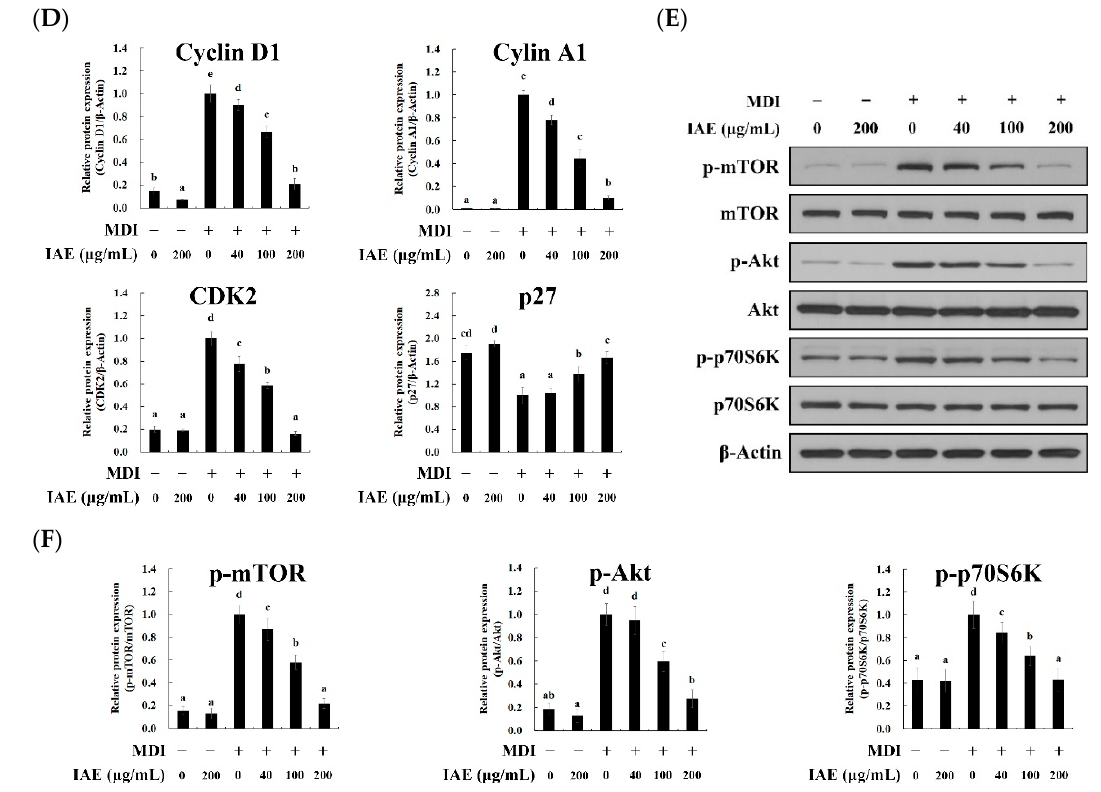
Figure 4. Inula britannica flower aqueous extract (IAE) inhibits the MCE involving Akt signaling pathways during early phase of adipogenesis. Growth-arrested 3T3-L1 preadipocytes were induced to differentiate by stimulating with MDI in the presence of indicated concentrations of IAE. The phosphorylation of cdc2 (Tyr15) and mTOR (Ser2448), Akt (Ser473), and p70S6K (Ser371) was examined to evaluate the activation of the G2/M phase and mTOR/Akt/p70S6K axis, respectively. ( A ) After 16 h of MDI treatment, cell cycle progression was investigated using FACS. ( B ) The cell distribution in the G0/G1, S, and G2/M phases was calculated as a percentage of total cell numbers based on the results of FACS analysis. ( C ) Western blotting was used to examine the expression of cell cycle progression-associated proteins after 18 h of MDI treatment. ( D ) Relative expression levels of representative proteins contributing to the transition of the cell cycle. ( E ) Effect of IAE on the activation of the mTOR/Akt/p70S6K axis after 18 h of MDI stimulation. ( F ) Relative expression levels of phosphorylated mTOR, Akt, and p70S6K. The data are presented as mean ± standard deviation. Values labeled with different letters are significantly different ( p < 0.05). Differences among the multiple groups were determined based on one-tailed one-way analysis of variance, followed by Tukey’s post hoc test.